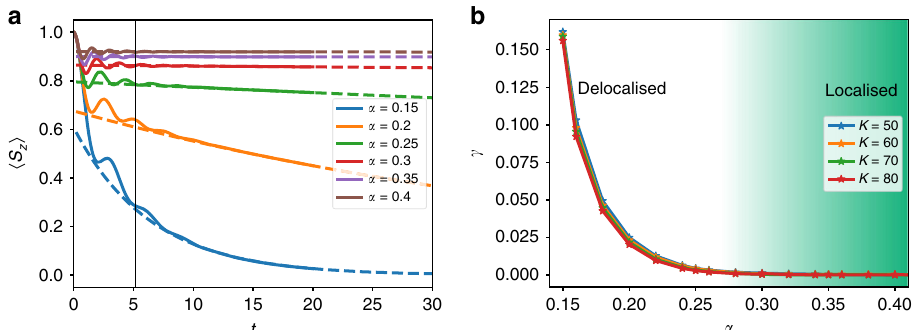
Fig. 3 Behaviour of the spin-1 system through the localisation phase transition. a The dynamics captured at K = 80 for the values of α indicated. The dotted lines show the exponential fi ts to the data. b The change in the decay rate as we go through the transition by varying α for the values of K indicated. The system parameters are the same as